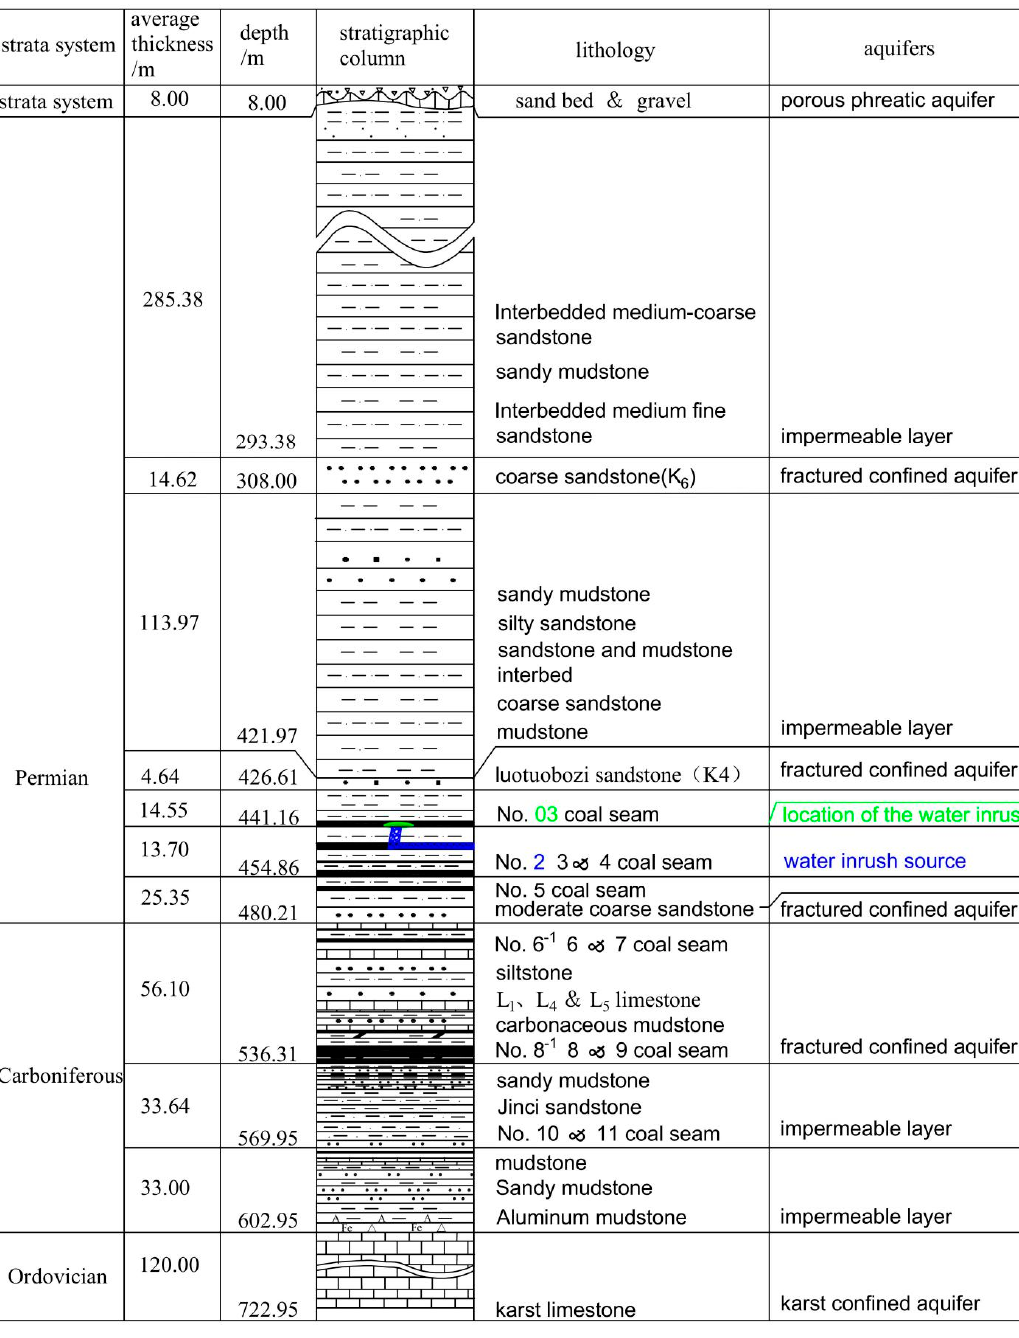
Figure 3. Strata and aquifer distribution at Dongyu coal mine. 4. The Accident Sequence and the Rescue Operations